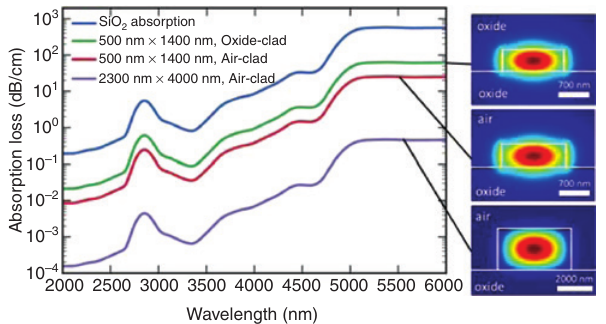
Figure 2: Calculated losses due to silicon dioxide absorption for differ- ent SOI waveguide layouts [9] (© 2017 Optical Society of America). The core sizes (height × width) and top cladding configuration are labeled, and the corresponding mode profiles are shown in the insets. Silicon dioxide absorption spectrum is also plotted for comparison. waveguides with a large Si core and no oxide top clad- ding can effectively mitigate such parasitic optical losses.